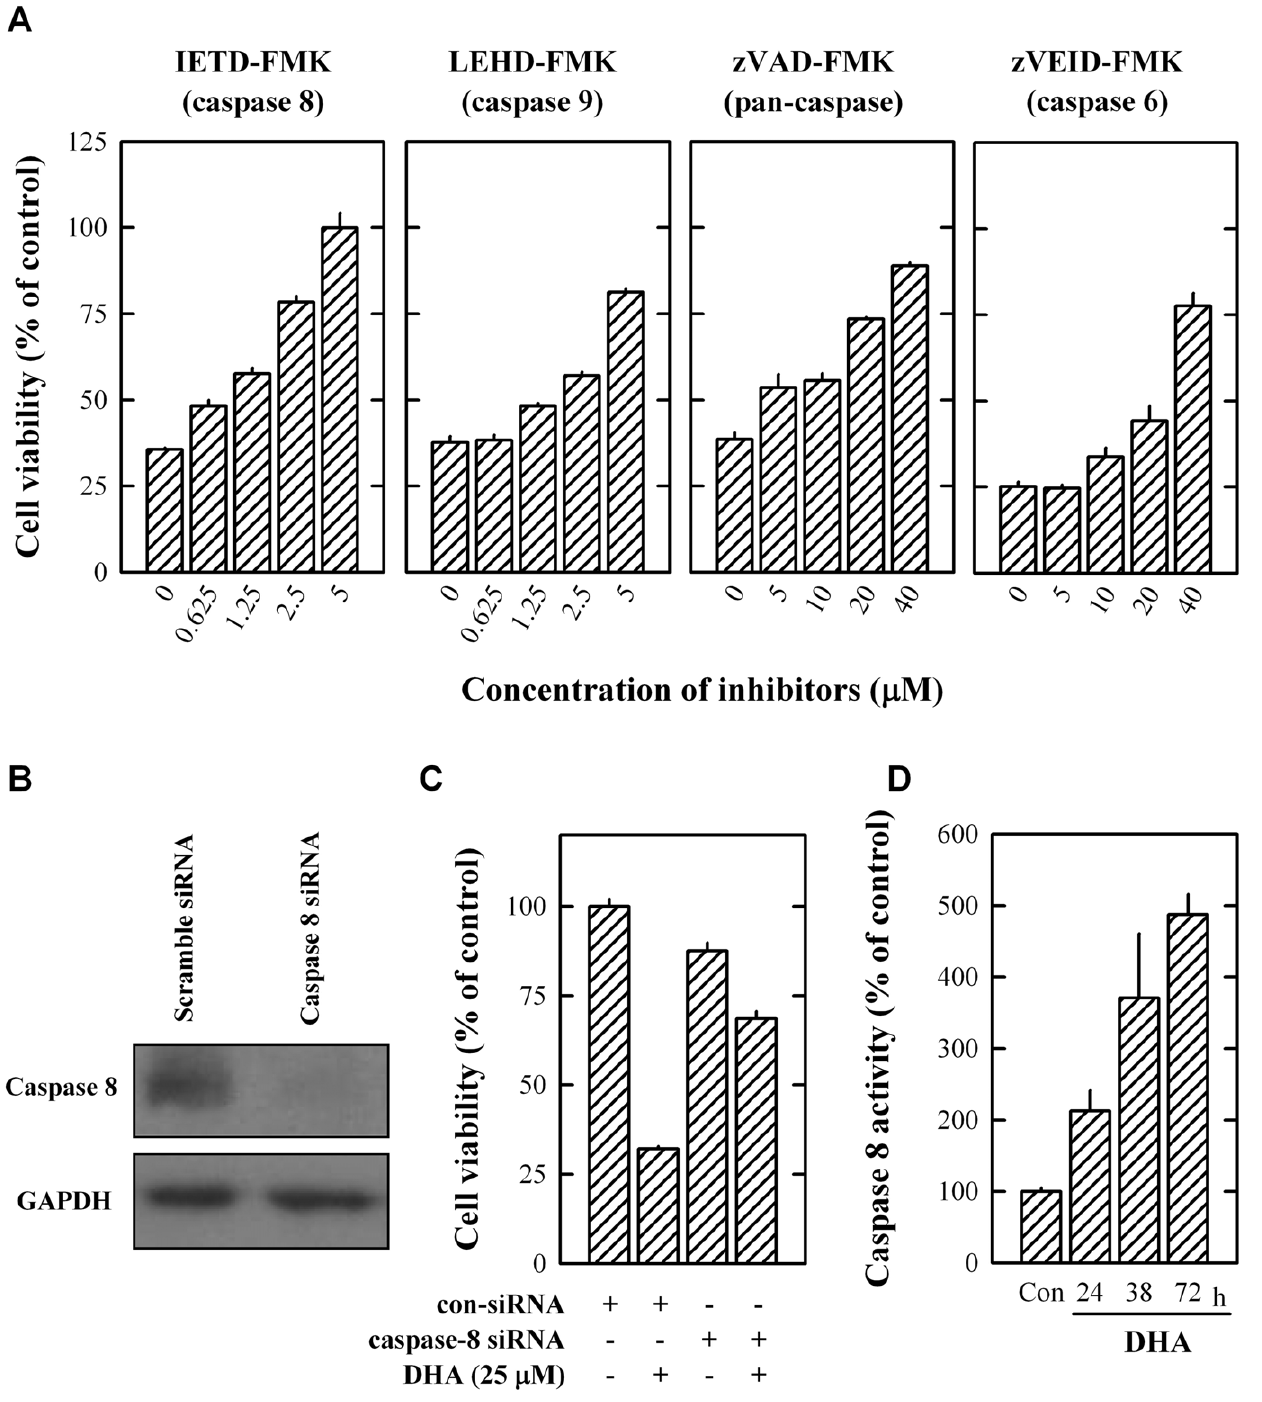
Figure 2. DHA-induced death of MCF-7 cells is mediated by caspase activation. ( A ) The protective effect of caspase inhibitors on 25 m M DHA-induced cell viability change of cultured MCF-7 cells. Cells were treated with DHA in the presence of different concentrations of the caspase inhibitor IETD-FMK (for caspase 8), LEHD-FMK (for caspase 9), zVAD-FMK (for caspases 1, 3, 4, 7), or zVEID-FMK (for caspase 6) for 72 h. Each value is the mean 6 S.E. (n=6). ( B ) Pro-caspase 8 protein expression level (Western blot analysis) in MCF-7 cells after transfection with scramble or caspase 8- specific siRNA (without DHA treatment). ( C ) The effect of caspase 8 knockdown on 25 m M DHA-induced death of cultured MCF-7 cells. Cells were first transfected with scramble or caspase 8-specific siRNA, and then they were treated with 25 m M DHA for additional 72 h. Each value is the mean 6 S.E. (n=6). ( D ) Time-dependent increase of caspase 8 activity in MCF-7 cells treated with 25 m M DHA for 24, 48, or 72 h. Each value is the mean 6 S.E. (n=3).